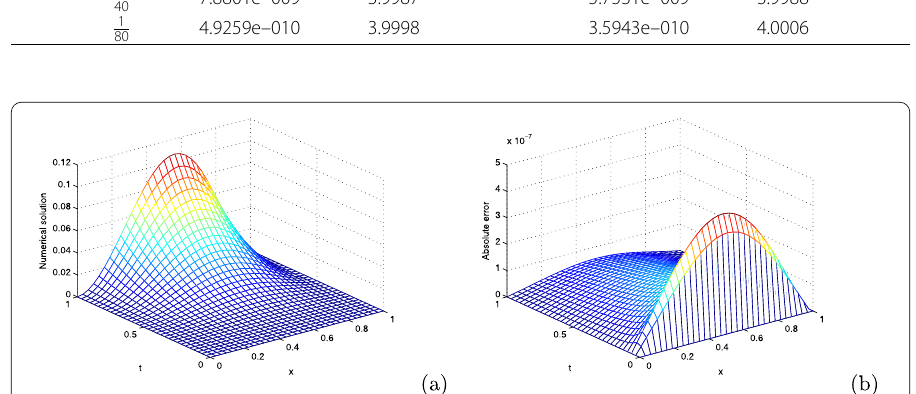
τ = 1/1000 is fixed. The numerical solution and the global error for α = 0.5, h = 1/32, τ = 1/32 are shown in Fig.